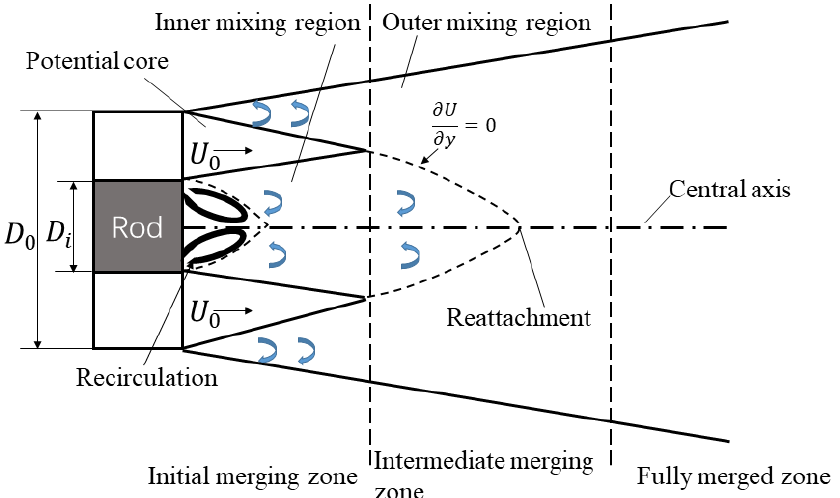
Figure 1. Schematic diagram of the flow pattern in a free turbulent annular jet following Chan and Ko